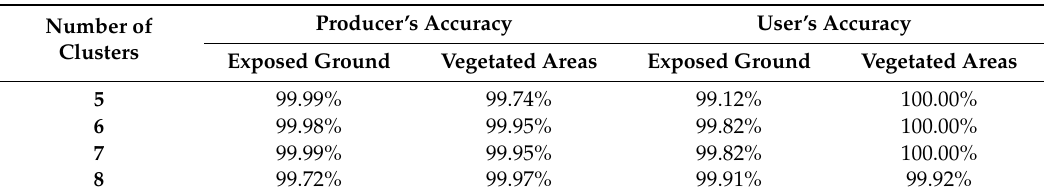
Table 8. Summary of the quantitative assessment of TLS segmentation results for exposed ground and vegetated areas when increasing the number of clusters.